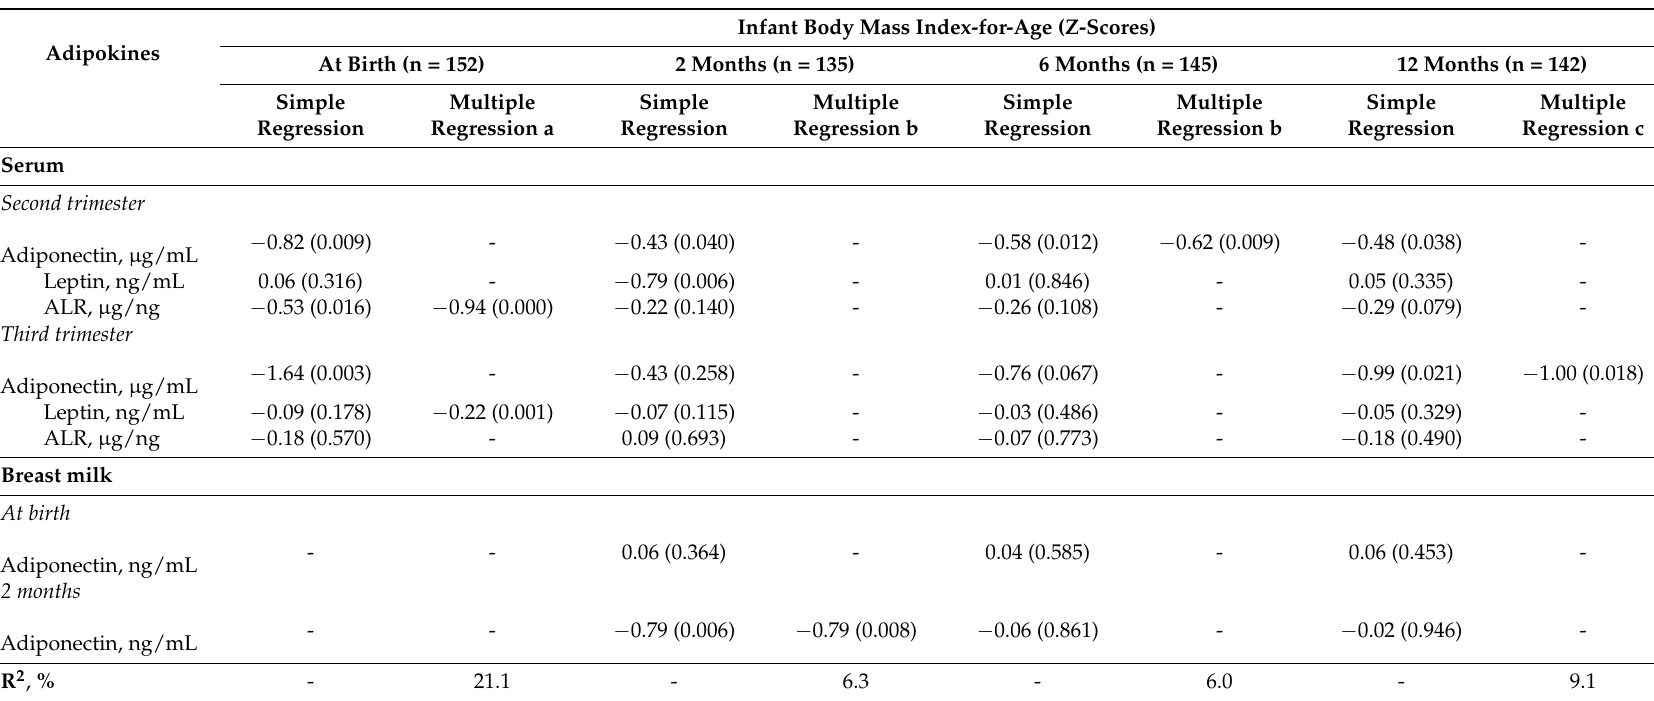
Table 4. Regression coefficients ( p -value) of maternal serum and breast milk adipokines on infant body mass index-for-age Z scores (BAZ). Infant Body Mass Index-for-Age (Z-Scores) Adipokines At Birth (n = 152) 2 Months (n = 135) 12 Months (n = 142) Simple Multiple Simple Multiple Simple Multiple Simple Multiple Regression Regression a Regression Regression b Regression Regression b Regression Regression